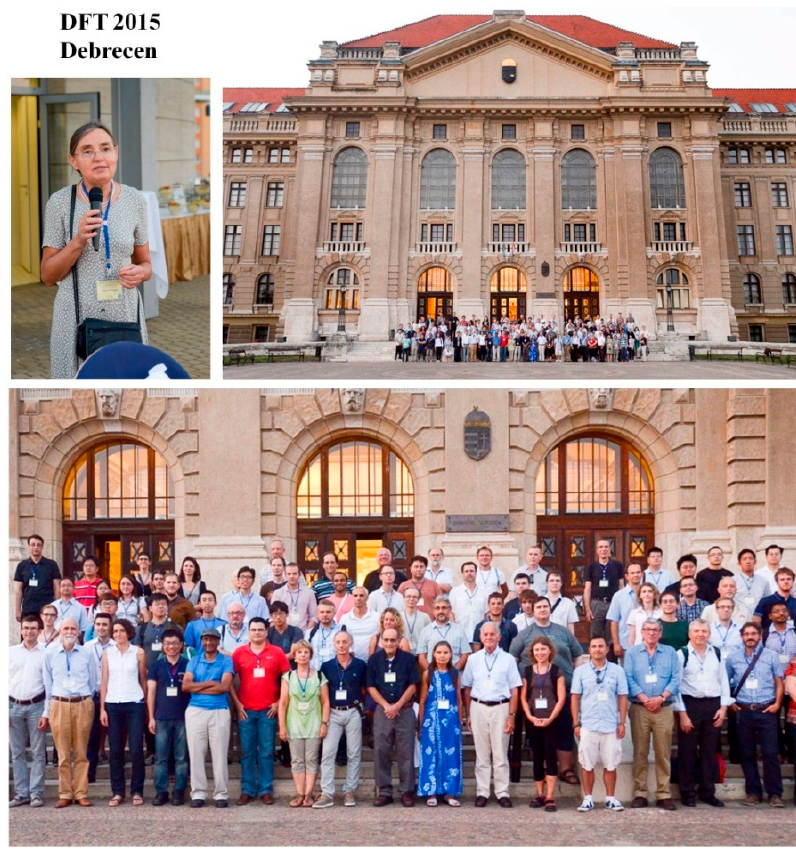
Figure 1. The DFT conference was organized by Ágnes Nagy ( left top ) and held in Debrecen, where, in front of the main building of the University of Debrecen ( top right ), a picture of the participants ( bottom ) was taken on 1 September 2015.